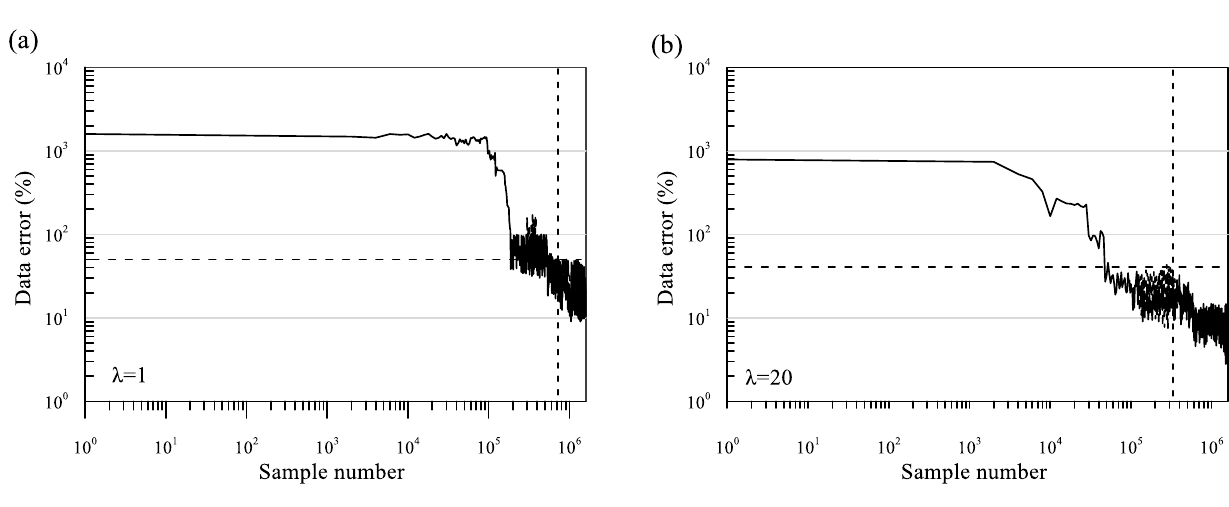
Fig. 6 Date error curves of MCMC inversion results of a six-layer model with Gaussian proposal distribution: a 𝜆 = 1 , b 𝜆 = 20 . The horizontal black dotted line is data error 50%, which is the thresh-